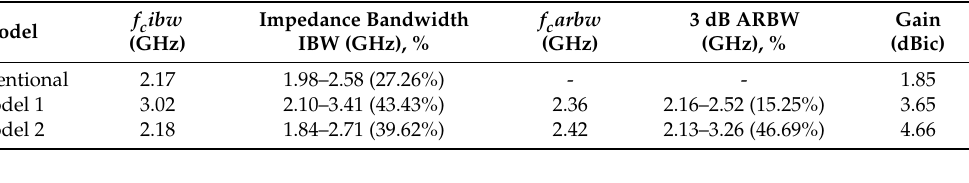
Figure 5. Comparison of the conventional model, model 1, and model 2: ( a ) S 11 , ( b ) axial ratio, and ( c ) antenna gains. Table 2. Performance of the CSA conventional model, model 1, and model 2.